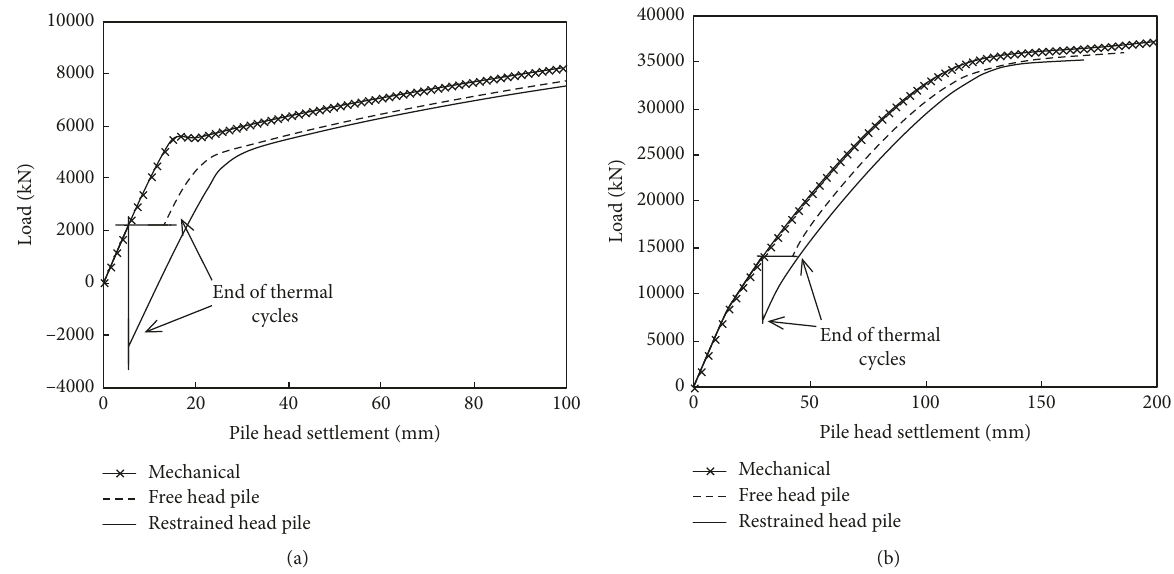
Figure 18: Comparison of load settlement curves of piles with and without thermal cycles. (a) Pile in loose sand. (b) Pile in dense